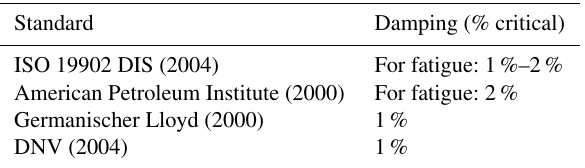
Table 1. Prescribed structural damping by different standards (Van der Tempel,